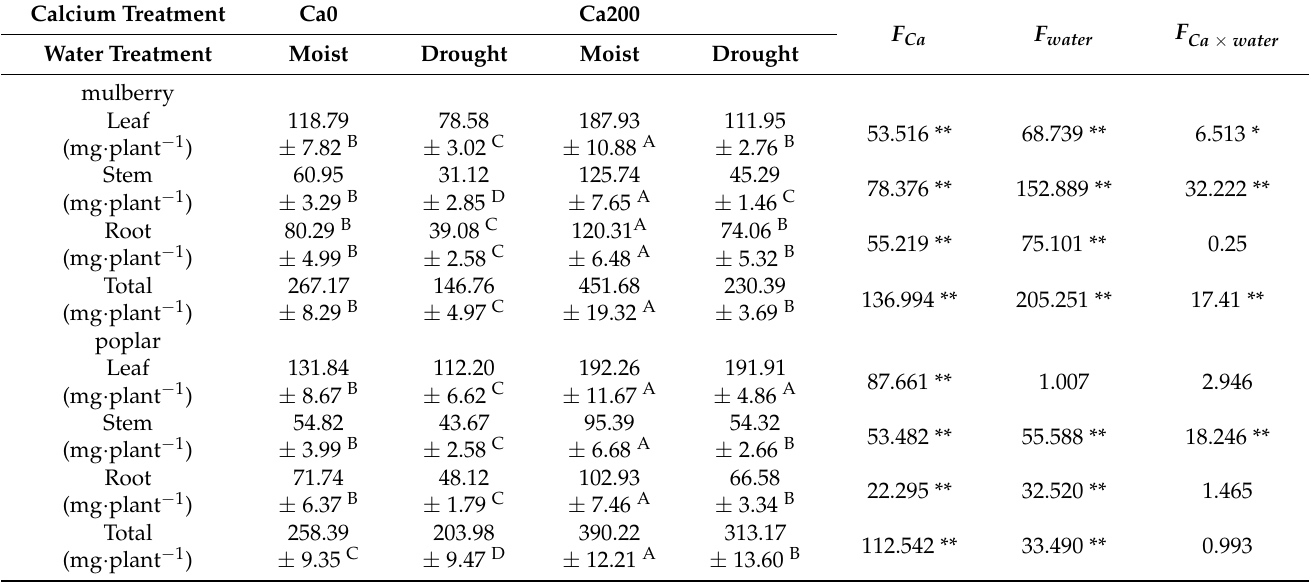
Table 3. Effect of water and Ca treatments on Ca content in leaf, stem, and root of the two species. Different letters indicate significant differences ( p < 0.05) among treatments. Treatment values shown as mean ± SE (n = 6). Results of the two − way ANOVA addressing effects of Ca and water treatments are summarized at the bottom. *, ** indicate that the F value is significant at p ≤ 0.05 and 0.01,